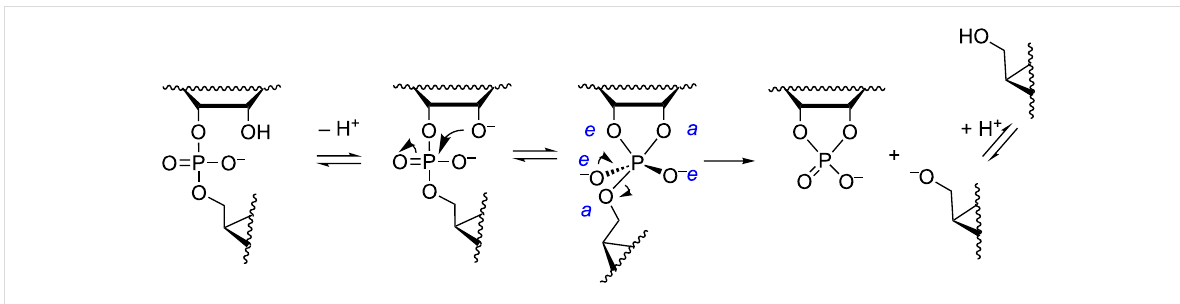
Scheme 3: Hydroxide-ion-catalyzed cleavage of RNA phosphodiester